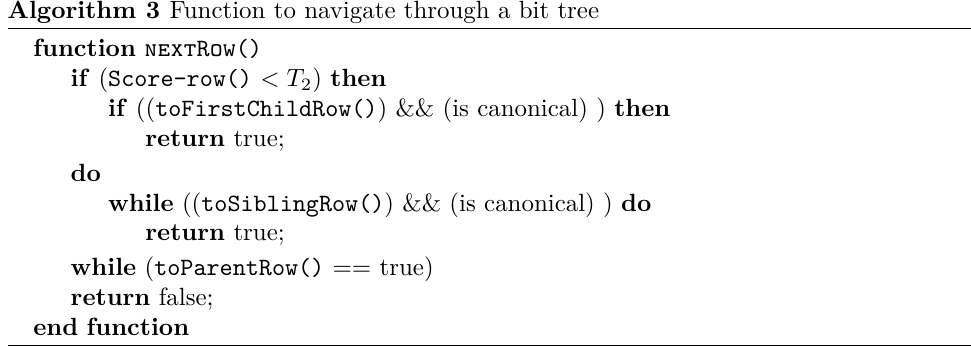
Algorithm 3 Function to navigate through a bit